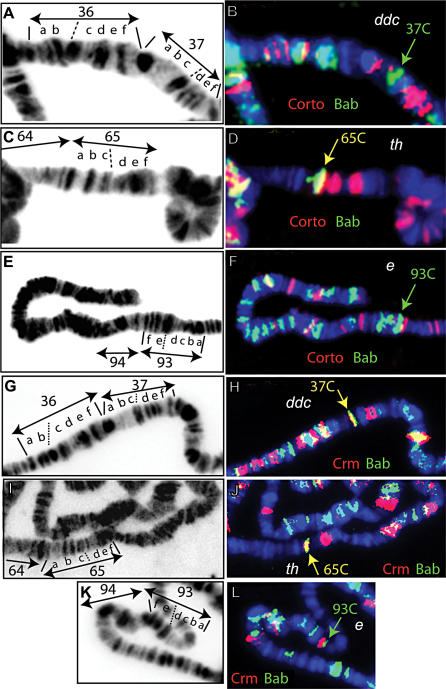
BAB Colocalizes with Chromatin Regulators on Polytene ChromosomesDouble immunostaining of polytene chromosomes with antibodies against BAB (green; B, D, F, H, J, and L), Corto (red; B, D, and F) and CRM (red; H, J, and L) in the cytological region of ddc (37C; A, B, G, and H), TH (65C; C, D, I, and J), and e (93C; E, F, K, and L). Colocalizations are indicated by yellow arrows. DAPI staining (blue) allows the visualization of euchromatic (lightly stained) and heterochromatic (densely stained) regions. Inverted black and white pictures of the DAPI staining are shown on the left to identify the cytological regions. Note the staining for BAB in the region of all three enzymes (B, D, F, H, J, and L), the colocalizations in the TH region with both Corto (D) and CRM (J), and in the ddc region with CRM (H).